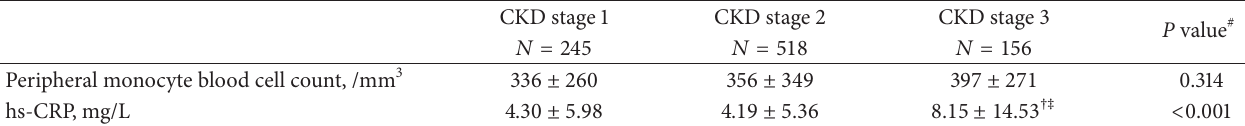
Table 2: The laboratory data about peripheral monocyte blood cell count and hs-CRP according to CKD stage. CKD stage 1 CKD stage